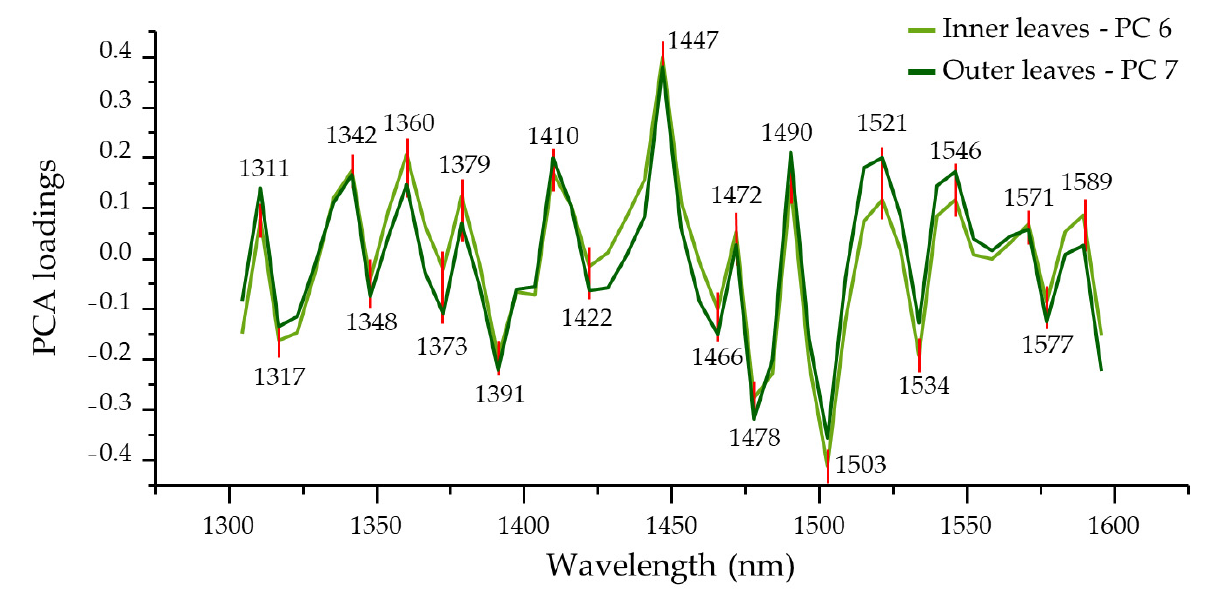
Figure 8. Selected PCA loadings of inner leaves (PC 6) and outer leaves (PC 7).